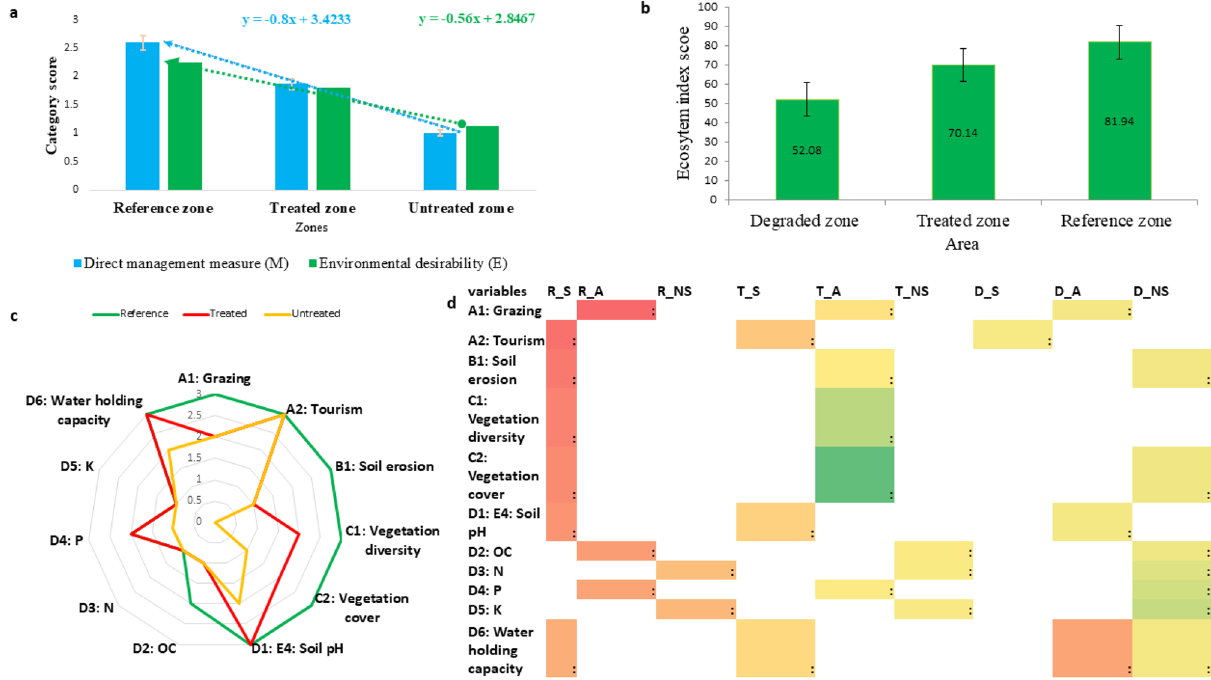
Figure 6. Evaluation of different components under restoration evaluation index; ( a ) category comparison between different zones, ( b ) ecosystem index score comparison between restore, reference and degraded zones, ( c ) evaluation of individual variables for their effectiveness in different zones, and ( d ) ecological profile of different zones (R_S = satisfactory for reference zone, R_A = average for reference zone, R_NS = not satisfactory for reference zone, similarly T = treated zone, D = degraded zone).